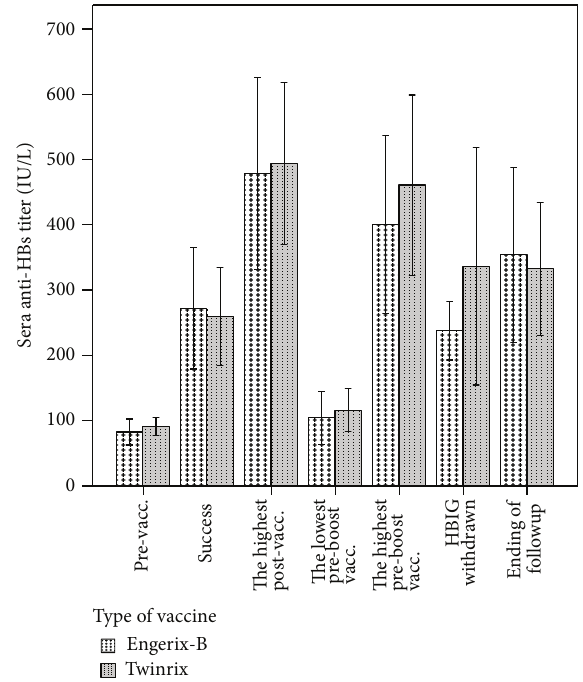
Figure 2: No significant differences were present in baseline anti- HBs titer, titer at successful establishment of immunity, the highest titer after vaccination, the lowest titer before booster vaccination, the highest titer after booster vaccination, titer when HBIG was withdrawn, and the titer at the end of followup (vacc.: vaccination).